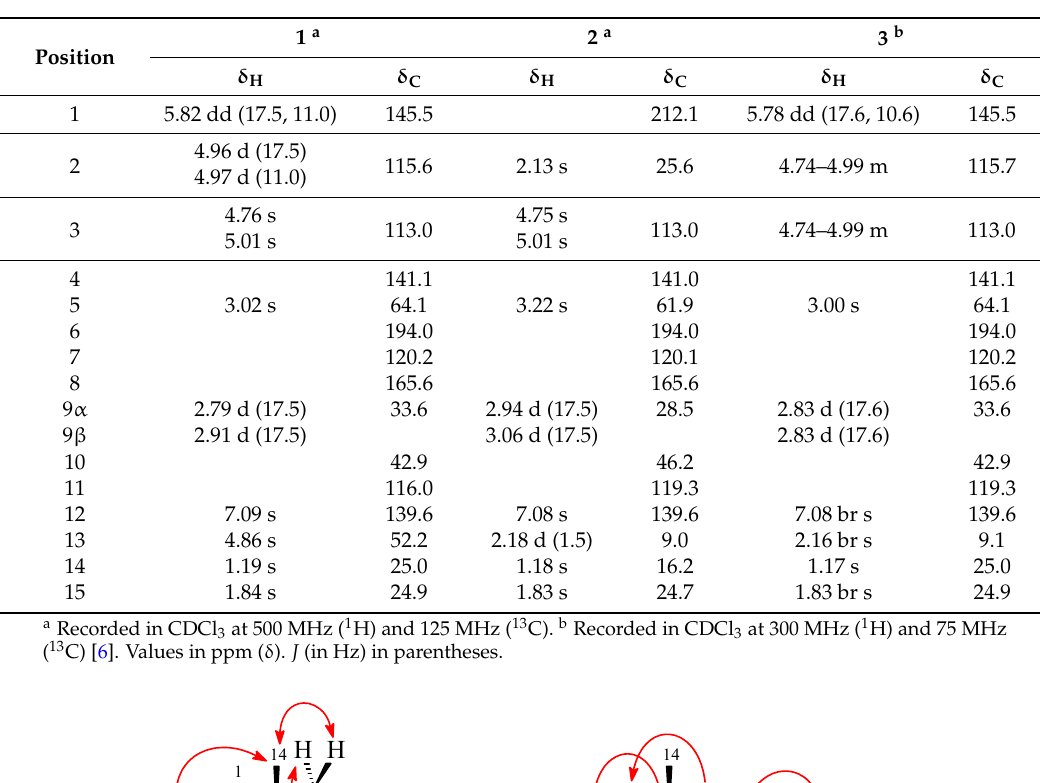
(b) Figure 4. Key ( a ) NOESY and ( b ) HMBC correlations of 2 .